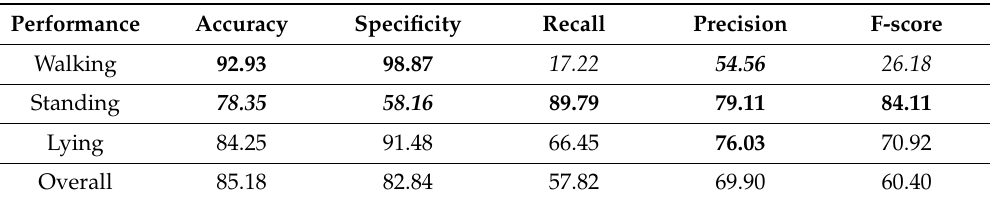
Table 4. Performance of the combined o ffl ine and online algorithm. In italics is the lowest value and in bold is the highest value across the di ff erent